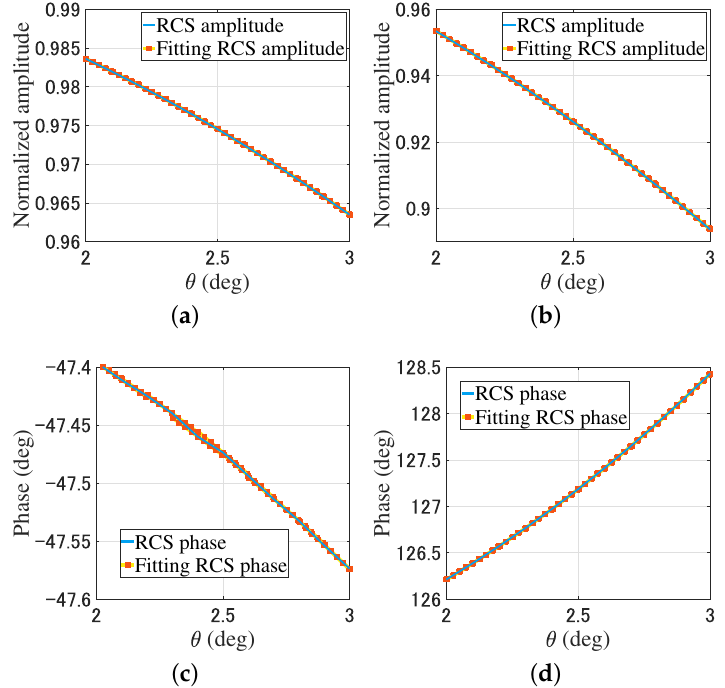
Figure 5. Comparison of the plate and trihedral corner reflector bistatic RCS. ( a ) The RCS amplitude of the plate. ( b ) The RCS amplitude of the trihedral corner reflector. ( c ) The RCS phase of the plate. ( d ) The RCS phase of the trihedral corner reflector.